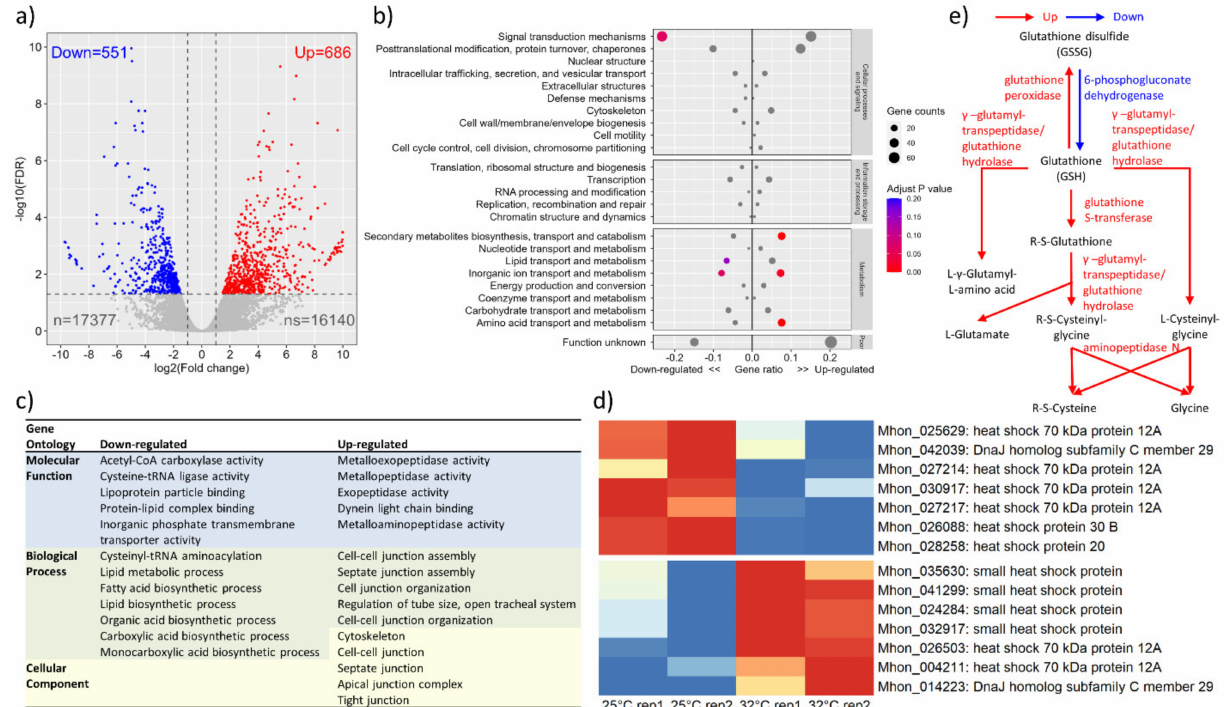
Figure 3. Transcriptome profiles of the oysters incubated under ambient (25 ◦ C) and heat-shocked (32 ◦ C) conditions. ( a ) Volcano plots showing distributions of DEGs; ( b ) KOG function enrich analysis; ( c ) top GO terms of DEG; ( d ) differentially expressed heat shock protein genes; ( e ) differential expression of genes involved in the glutathione metabolism under heat shock